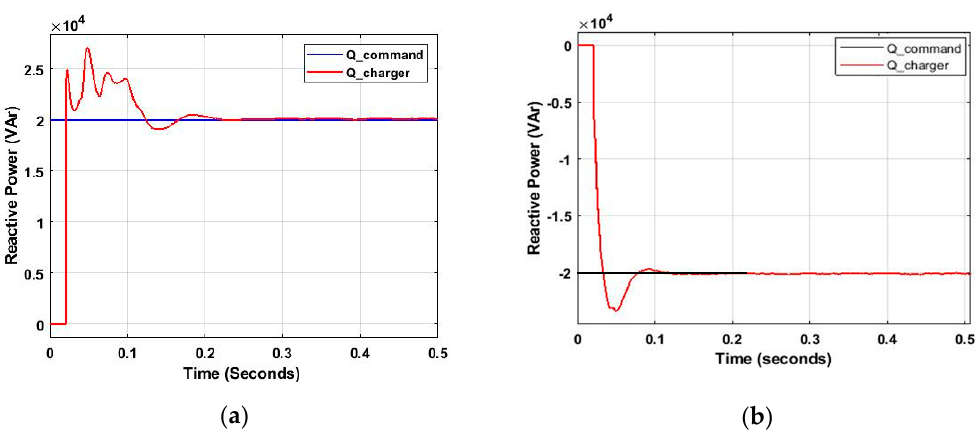
Figure 12. Charger’s response (red) to reactive power request (blue): ( a ) inductive reactive power and ( b ) capacitive reactive power.